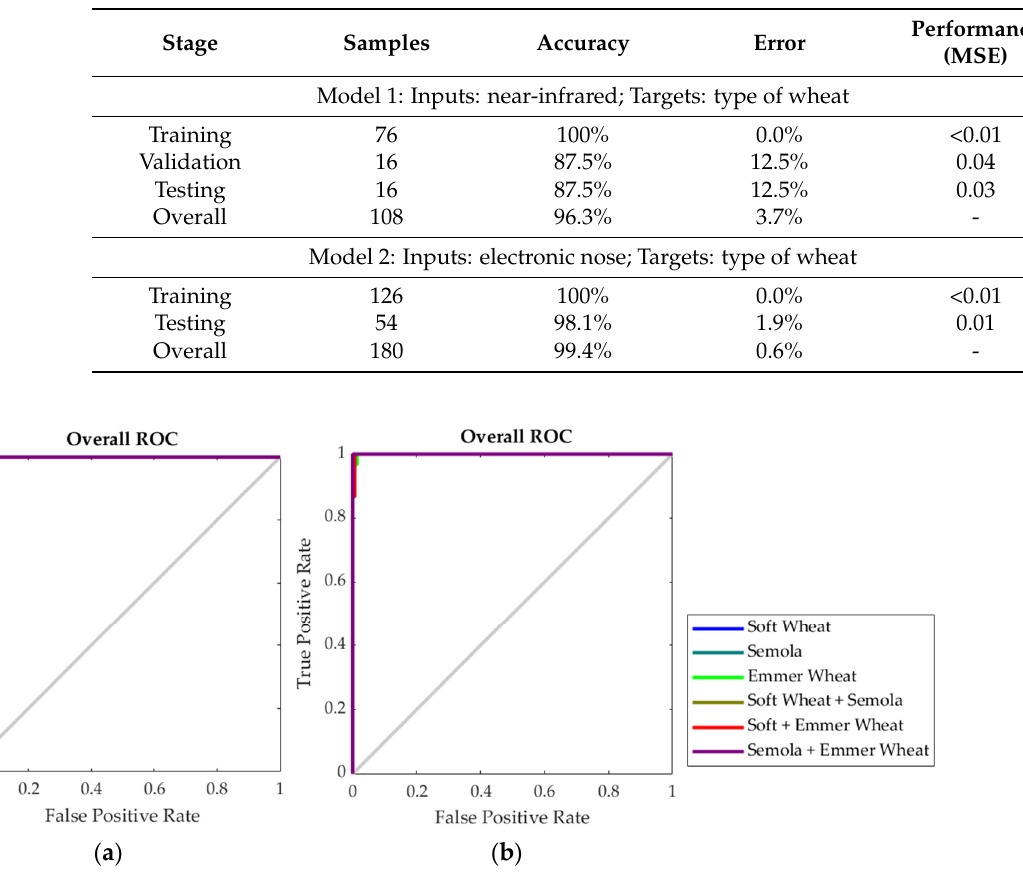
Table 4. Classification artificial neural network results for Models 1 and 2. Abbreviations: MSE: means squared error.